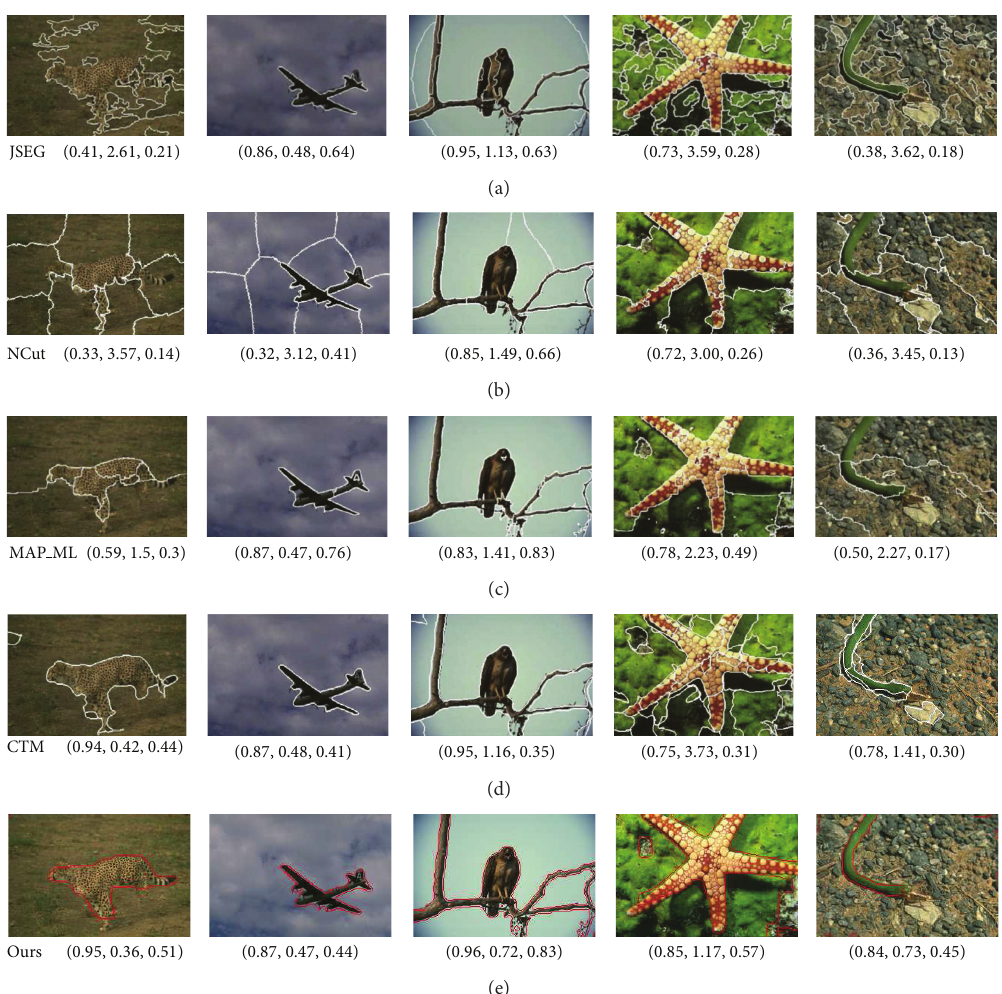
Figure 6: Segmentation results of some texture images with PRI, VoI, and 𝐹 -measure values presented in parenthesis: (a) is the results by JSEG method, (b) is the results by NCut method, (c) is the results by MAP-ML method, (d) is the results by CTM method, and (e) is the results by our proposed method. Table 1: Time consumption comparison of the Split-Bregman method with traditional gradient descent method.